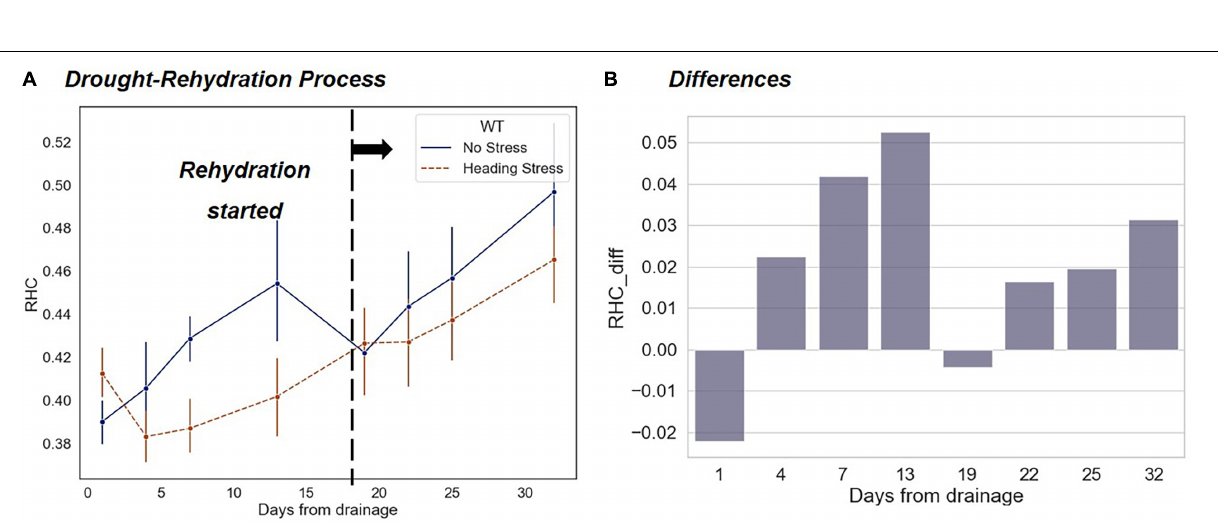
Frontiers in Plant Science |